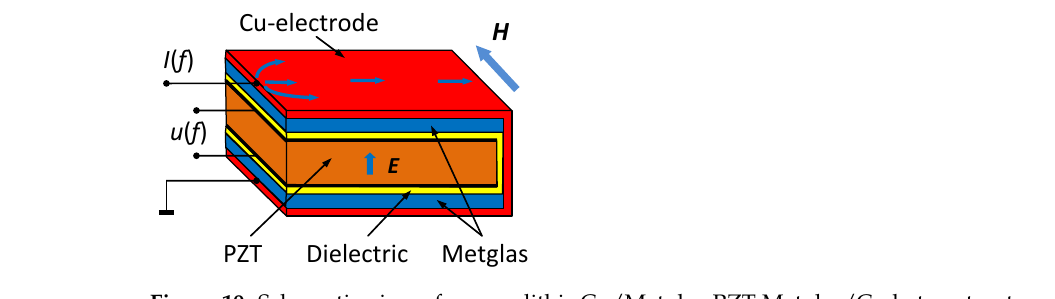
Figure 19. Schematic view of a monolithic Cu/Metglas-PZT-Metglas/Cu heterostructure with an integrated “magnetic capacitor” excitation system. The arrows show directions of electric E and magnetic H fields.